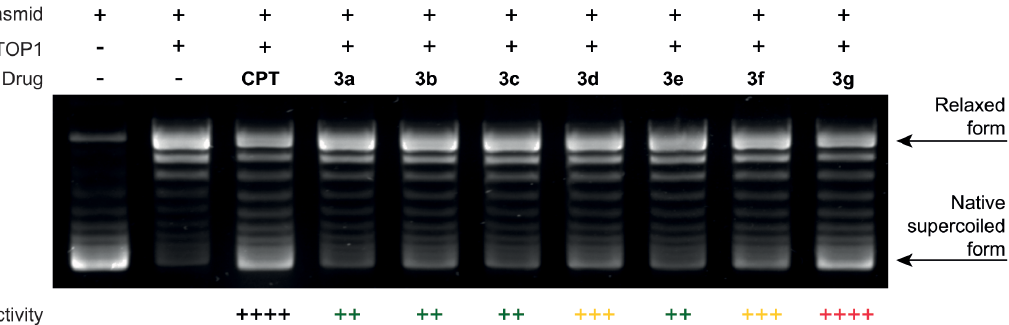
Figure 5. DNA relaxation inhibition assay. Drug concentration was 10 m M. Activities are expressed relative to that of camptothecin (CPT): ( + ) 1– 25%, ( ++ ) 26–50%, ( +++ ) 51–75%, ( ++++ ) 76–100% of the CPT inhibition. All compounds were at least as potent as luotonin A and compound 3g showed a remarkable activity, comparable to that of camptothecin.